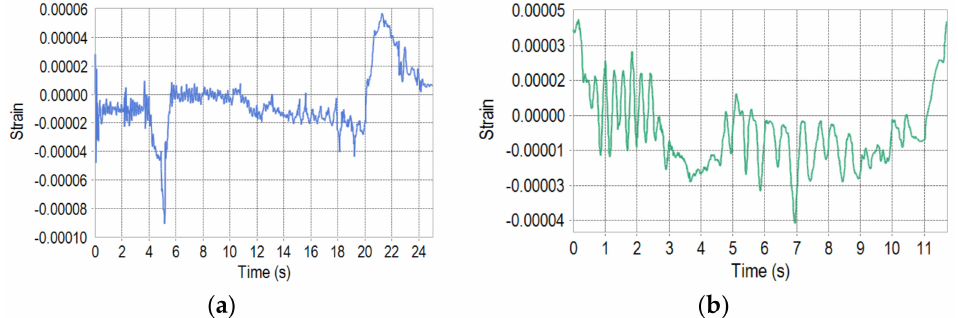
Figure 15. Strains of the left push arm: ( a ) simulation results; ( b ) experiment results.